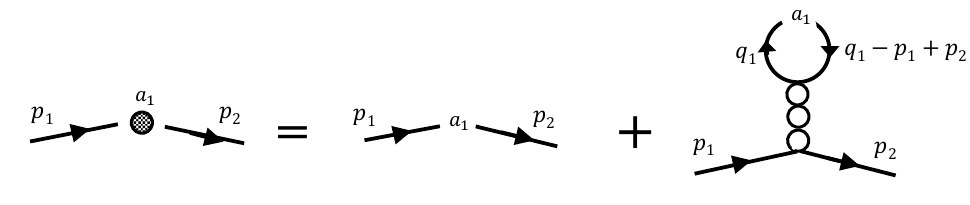
, in the chiral limit. ! 1